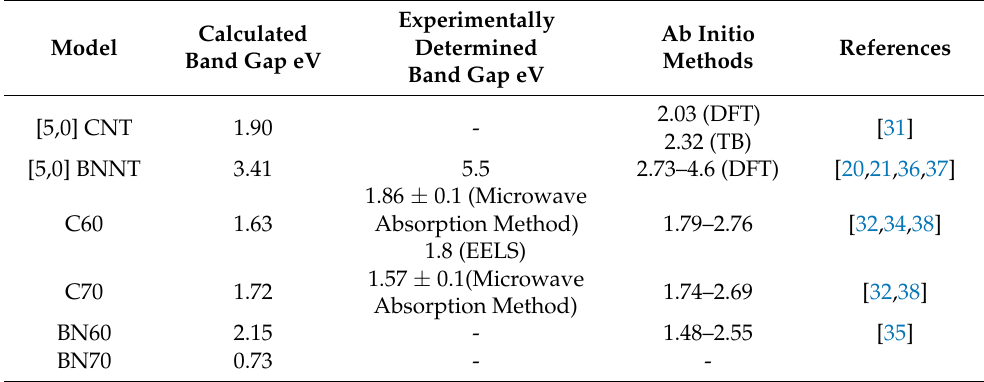
Table 1. Summary of band gaps calculated compared with experimentally available data and other similar ab initio methods.